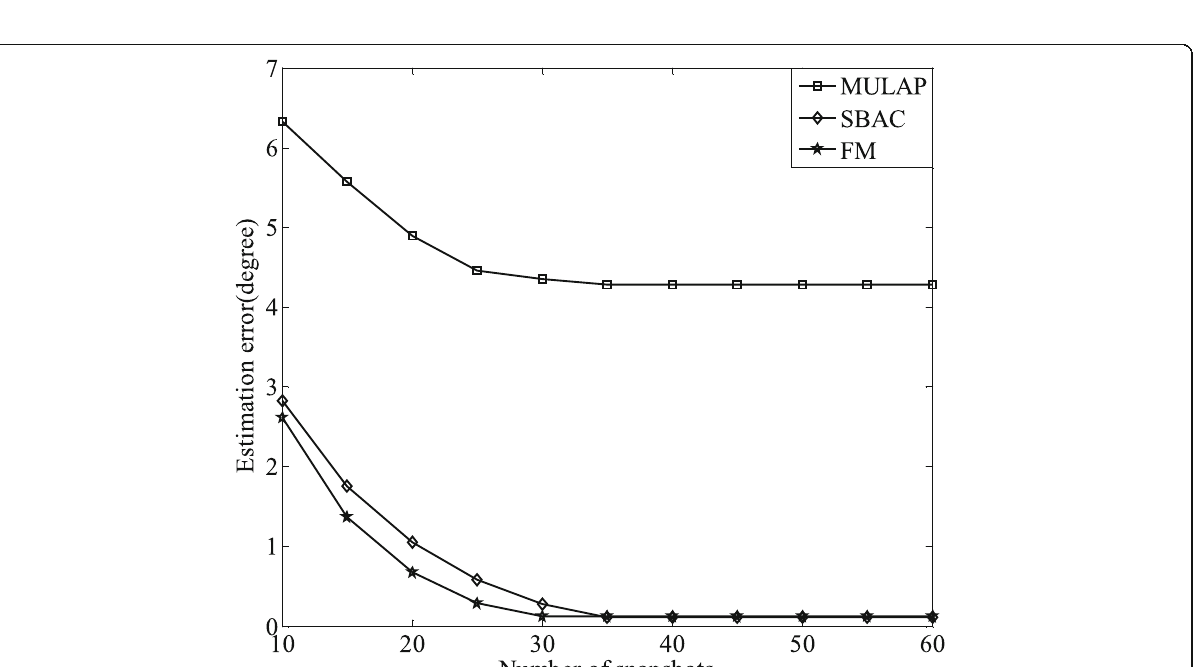
Fig. 8 Estimation errors versus number of snapshots when FS and NS are close to each